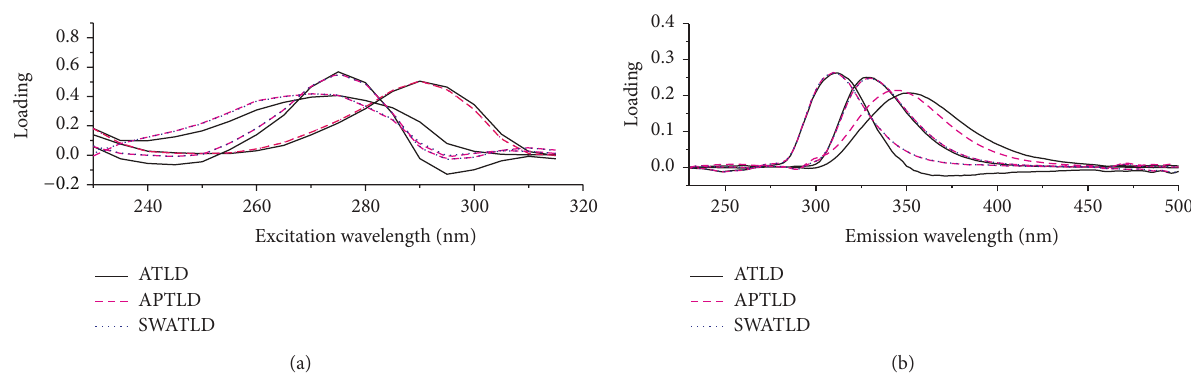
Figure 4: Comparison of the resolved and actual excitation and emission profiles corresponding to three kinds of models with the same number of components.